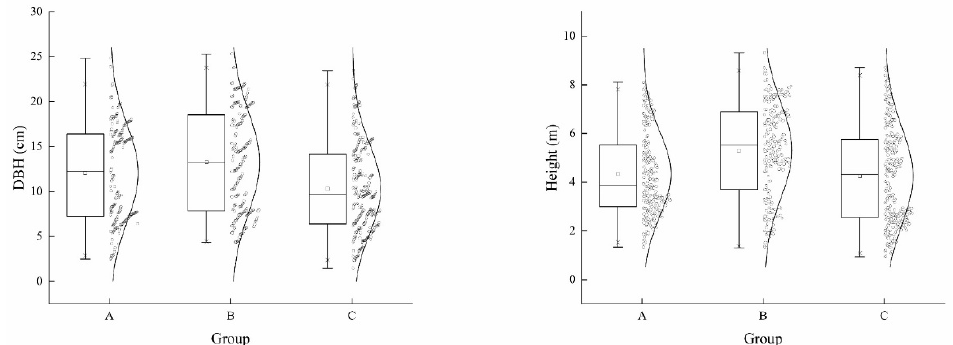
Figure 7. Distribution pattern of tree DBH and height in the three groups of resettlement residential areas in